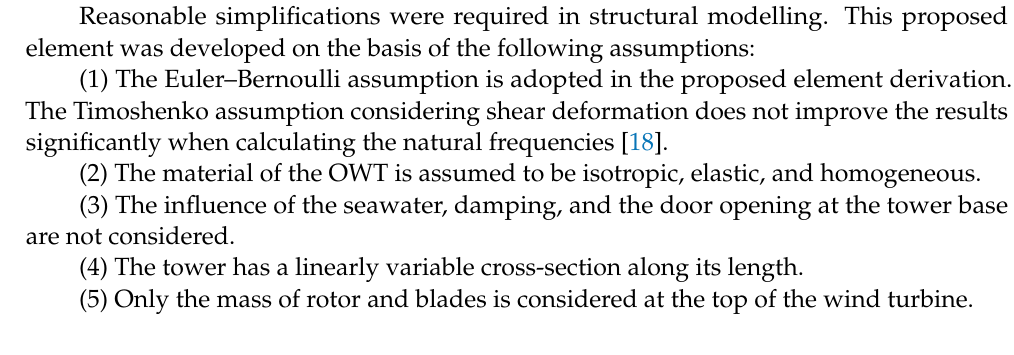
Figure 3. Proposed unified beam-column element model for OWT system.